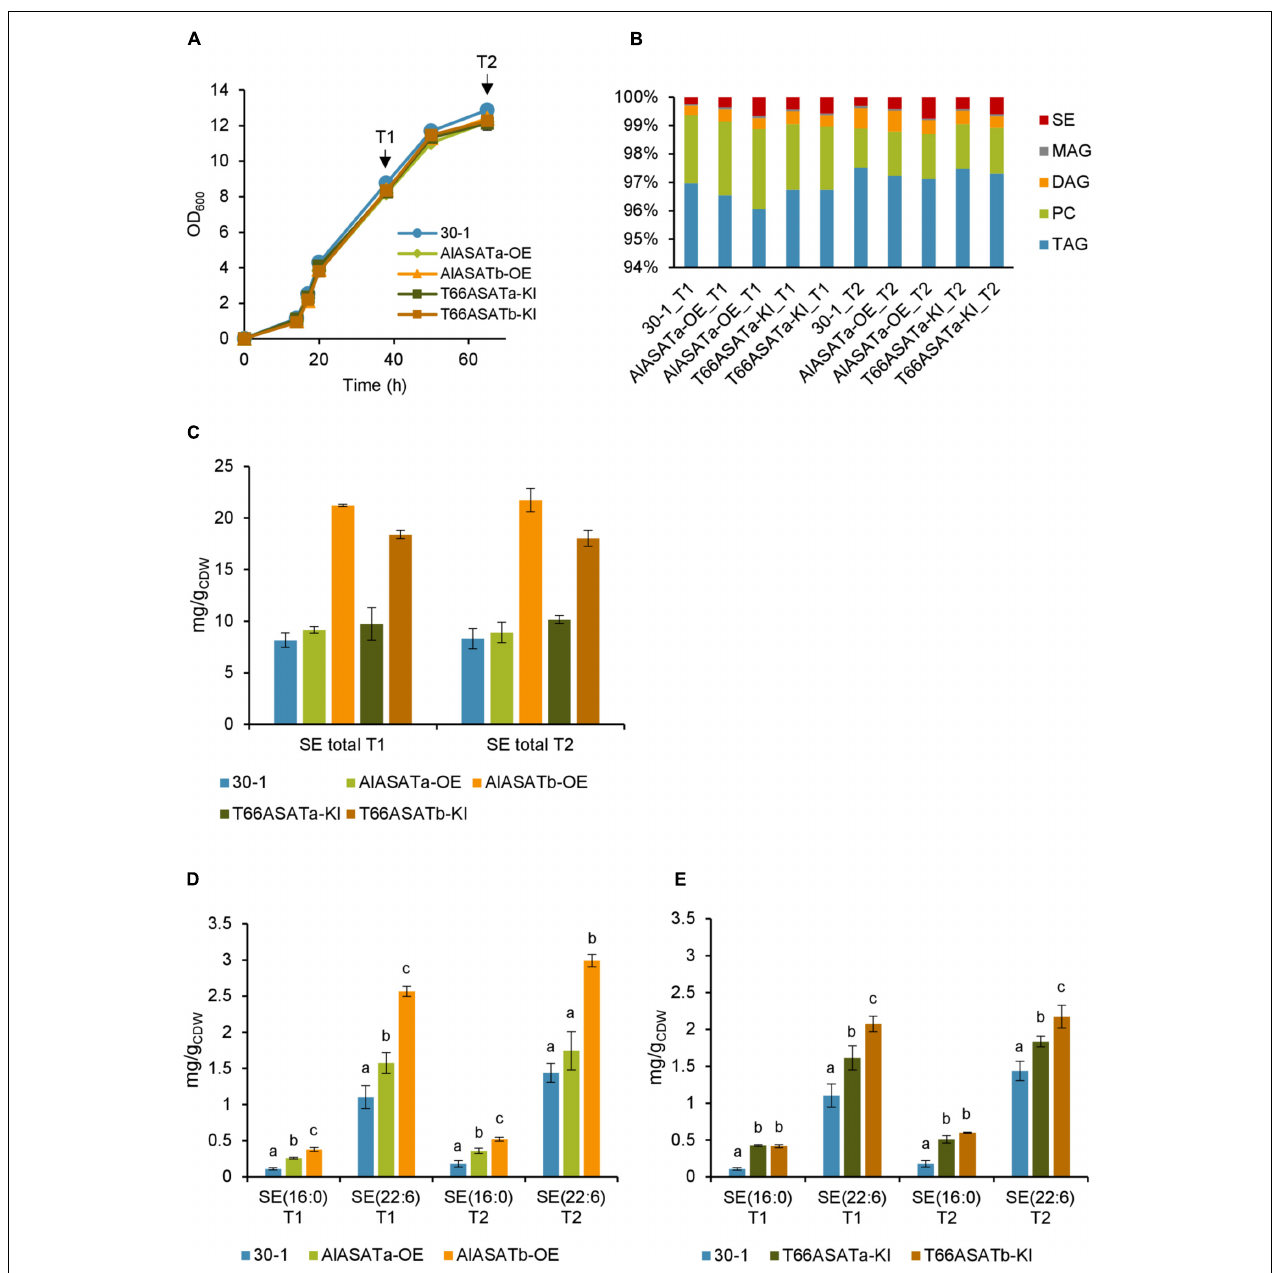
FIGURE 5 | Characterization of the SR21 OE and KI strains compared to strain 30-1. (A) Growth measured as optical density (OD 600 ), sample collection points are indicated by arrows. (B) Distribution of different lipid classes. TAG, Triacylglycerol; DAG, diacylglycerol; PC, phosphatidylcholine; MAG, monoacylglycerol; SE, steryl ester. The production (mg/g CDW ) of total SE (C) and SE species (D) from OE (D) and KI (E) strains, shown by the normalized abundance. All data are expressed as the mean of the triplicates originating from three independent cultures, except data from T66ASATb-KI at T2 that originate from two independent cultures. Error bars represent the standard deviation. The bars are separated into groups, each with a particular SE and time points. For each group, the bars with different lowercase letters on the top are statistically significantly different from each other ( P < 0.05), based on one-way analysis of variance (ANOVA), followed by post hoc Tukey